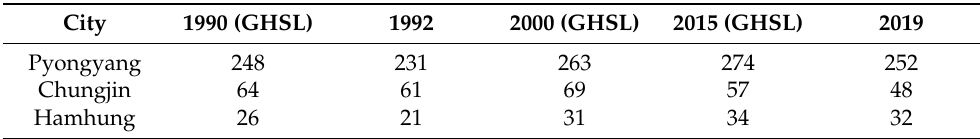
Table 5. Robustness of main results assessed using Global Human Settlement Layer (GHSL) data [km 2